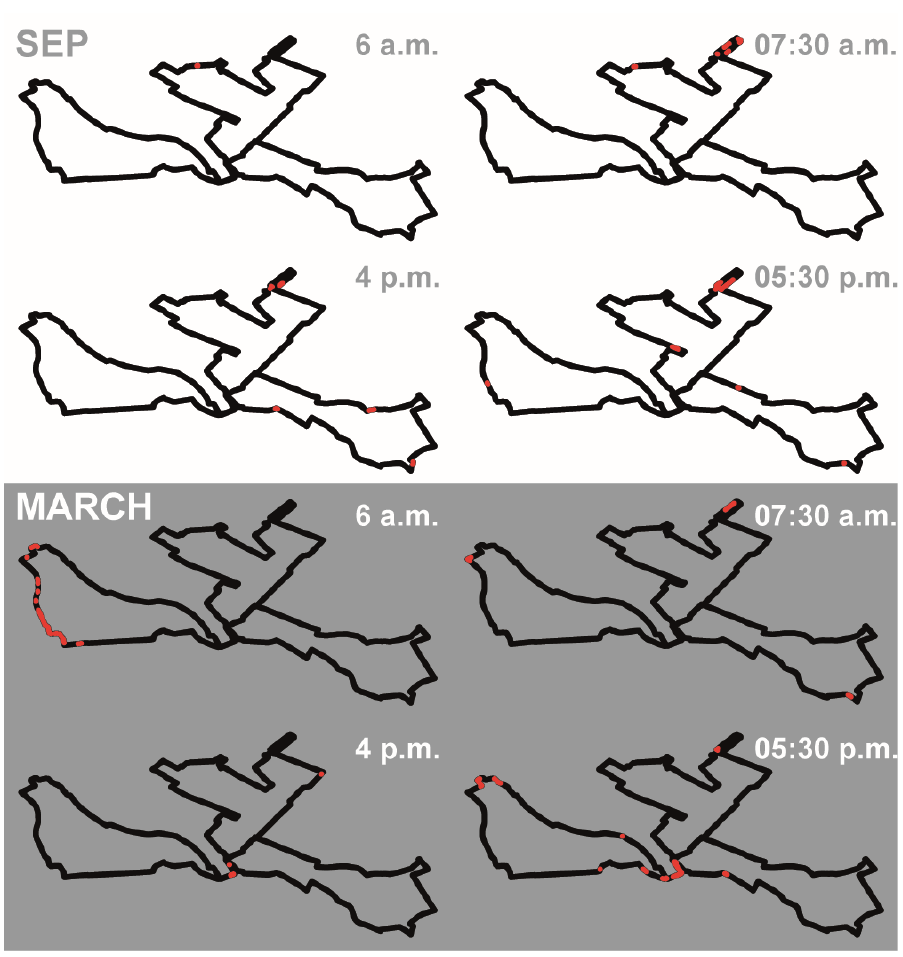
Figure 5. Locations showing the 10% highest PM 2.5 concentrations (red dots) throughout the runs during the September and March campaigns. during the September and March